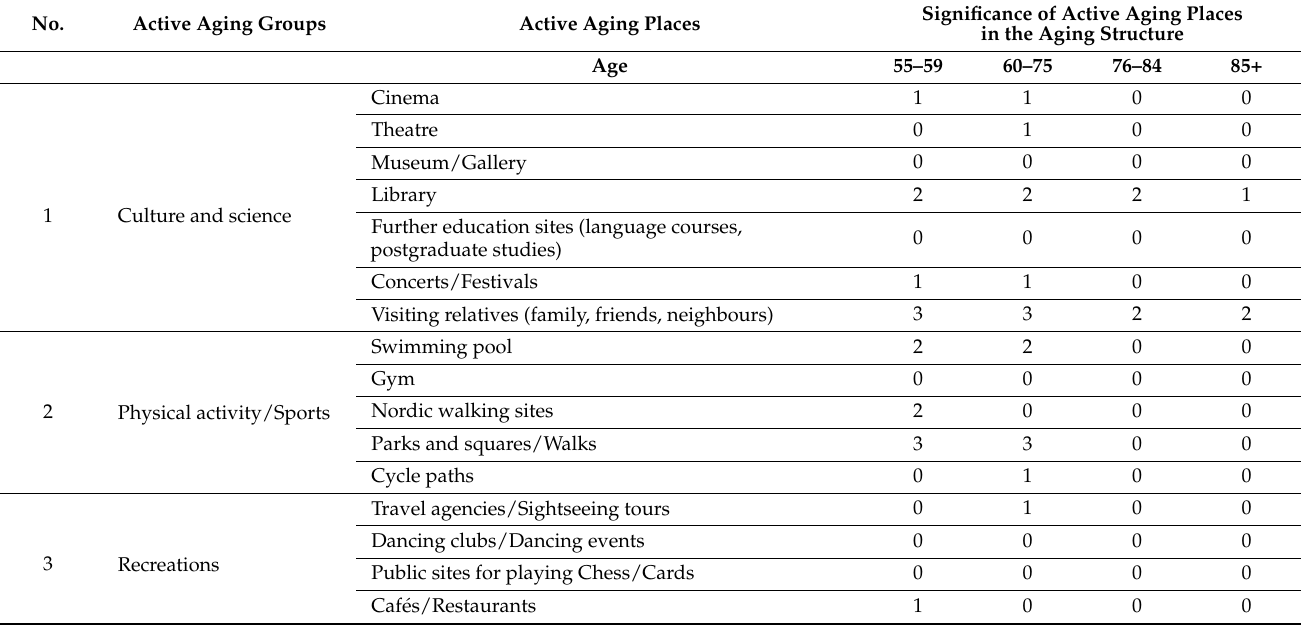
Table 13. Active aging groups and places in the city. Source: own elaboration based on [14]. No. Active Aging